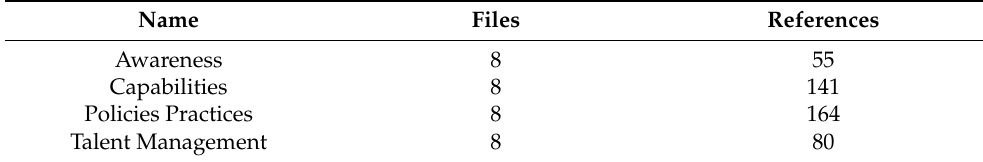
Table 2. Aggregated code